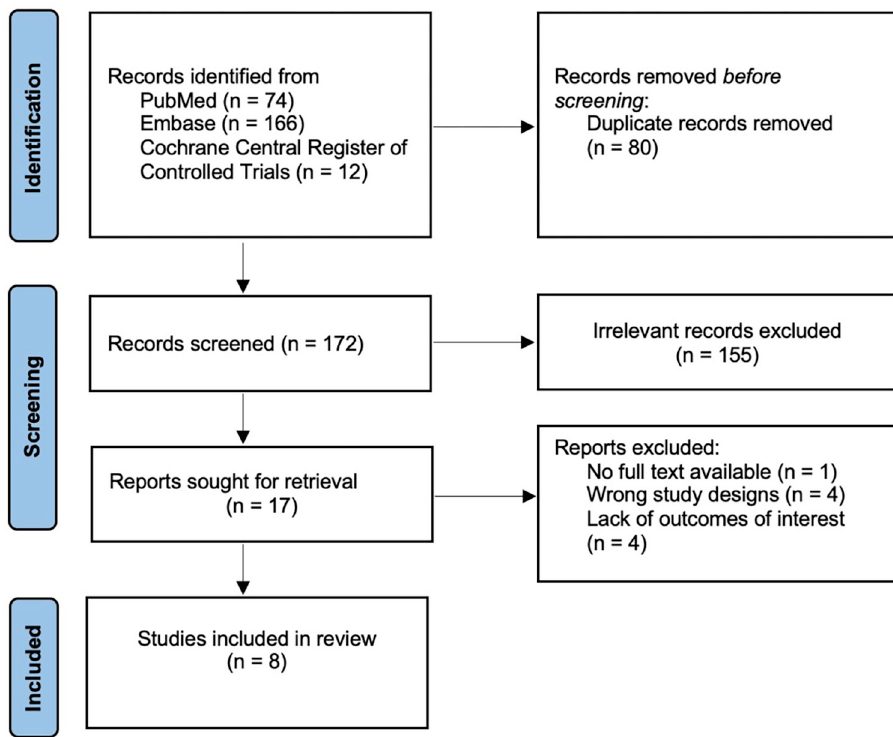
Fig 1. Search methodology and selection